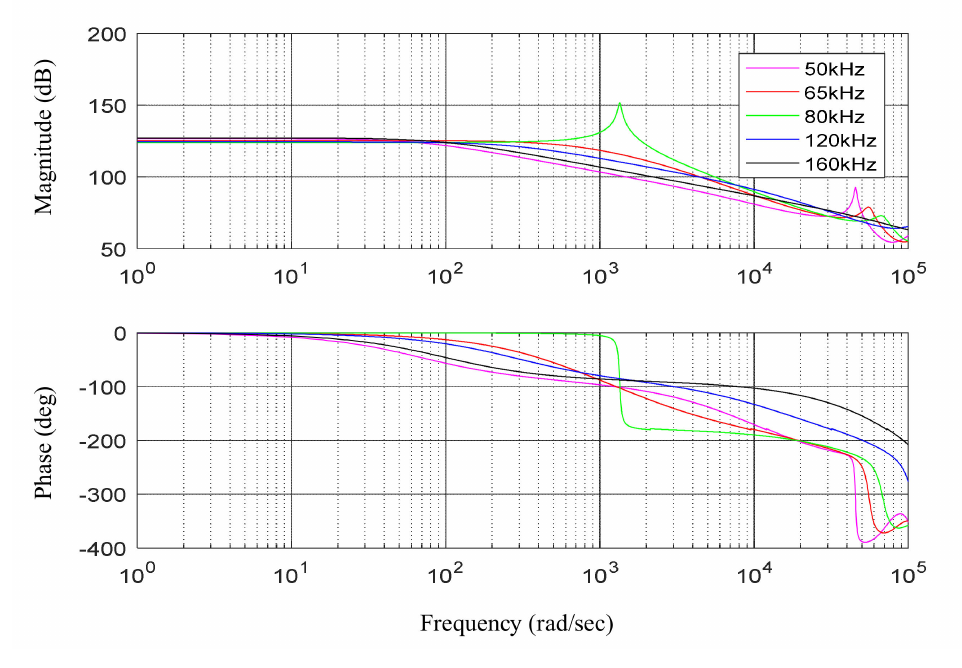
Figure 8. Bode diagram of system transfer function Gvt .